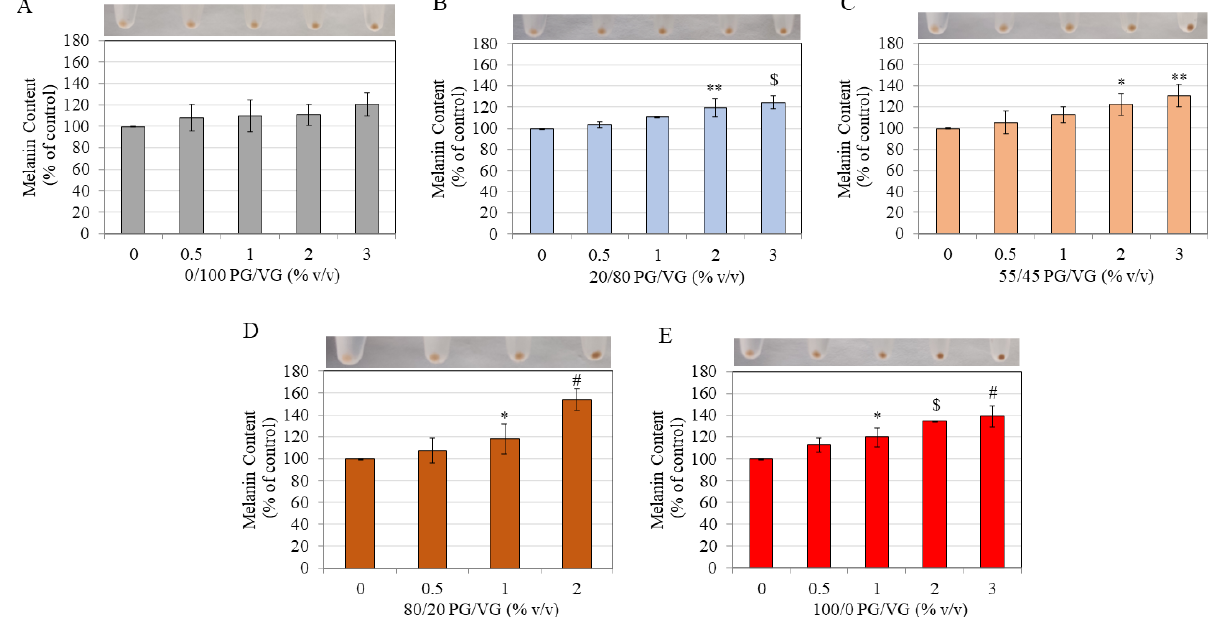
Figure 2. Melanin content in lysates of human melanocytes after 48 h exposure to e-liquids containing PG/VG at a ratio of ( A ) 0/100; ( B ) 20/80; ( C ) 55/45; ( D ) 80/20 and; ( E ) 100/0, at concentrations: 0, 1, 2, 3, 5, 10% v/v; the panel in each graph shows the corresponding photos of pellets of melanocytes exposed to compounds at each concentration; (One-way ANOVA with Dunnett’s post hoc test; * p < 0.05, ** p < 0.01, $ p < 0.001 and # p < 0.0001 vs. untreated control). Data for ( D ) is mean ± SD of four independent experiments while all other data is mean ± SD of three independent experiments.